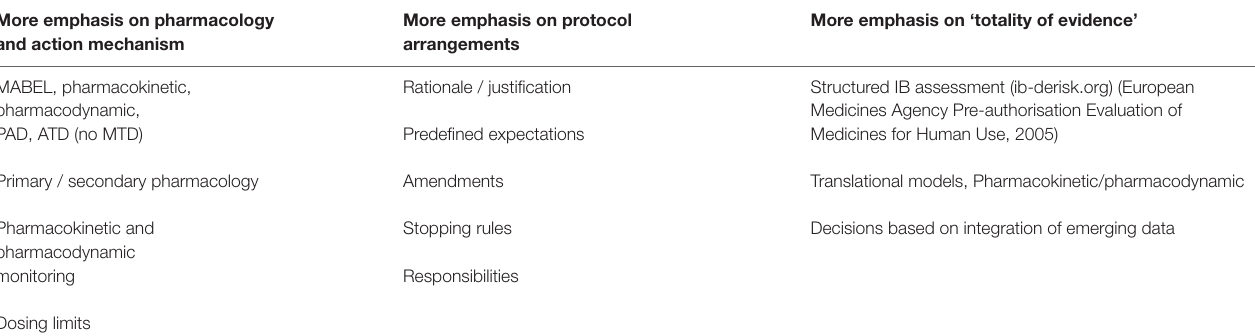
TABLE 2 | A summary of the essential changes in the revised EMA FIH